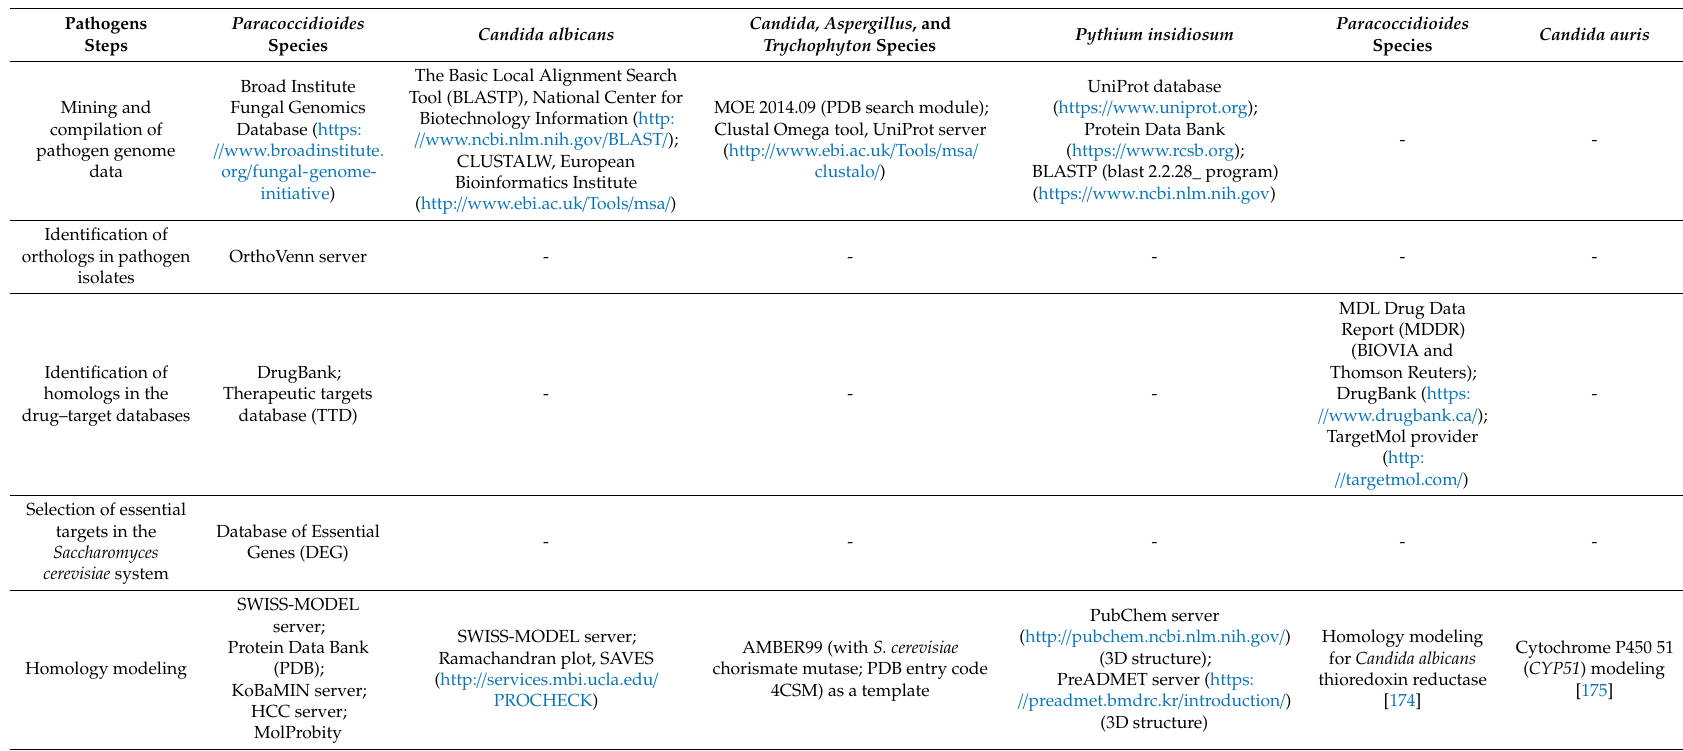
Table 1. Tools and procedures applicable to the in silico / computational antifungal drug